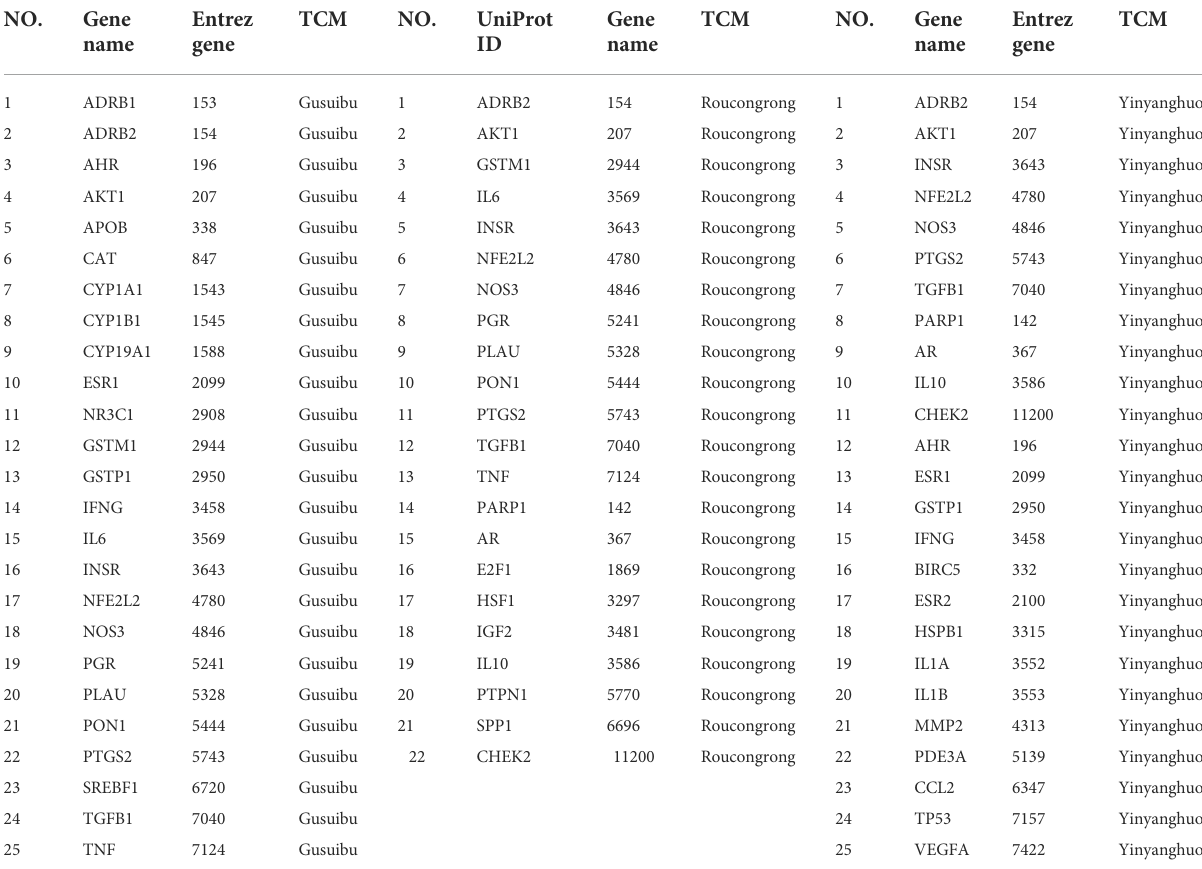
TABLE 2 Database-based infertility treatment targets of Roucongrong, Yinyanghuo and Gusuibu.